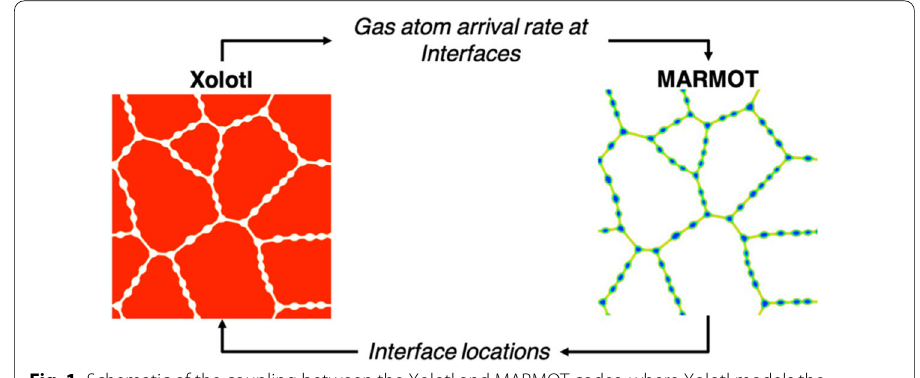
Fig. 1 Schematic of the coupling between the Xolotl and MARMOT codes, where Xolotl models the clustering and transport of gas atoms within the grains and MARMOT models bubble growth and